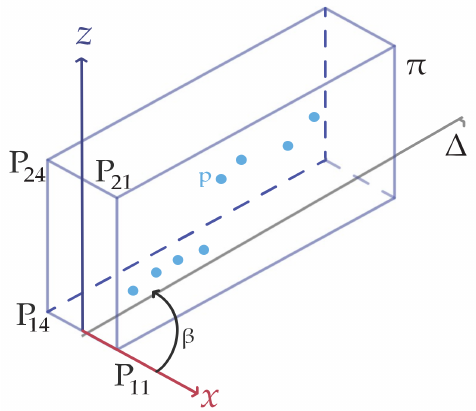
Figure 3. A single rectangle cut out of the scanned points.